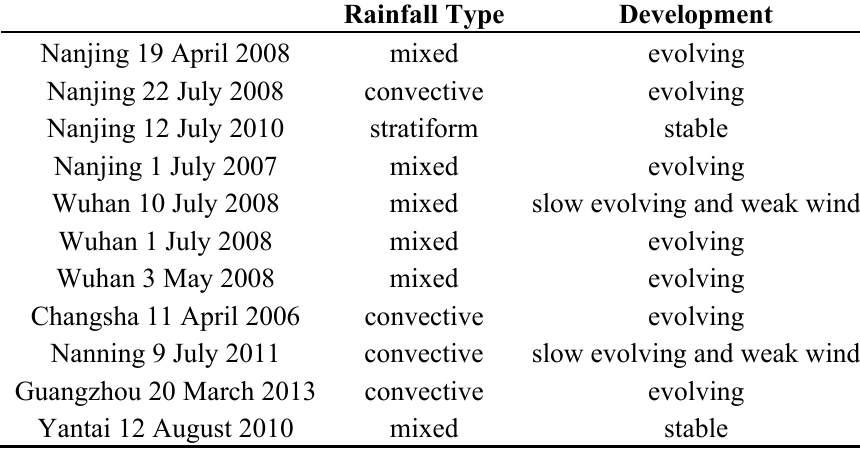
Table 2. The description of the 11 cases within their analysis